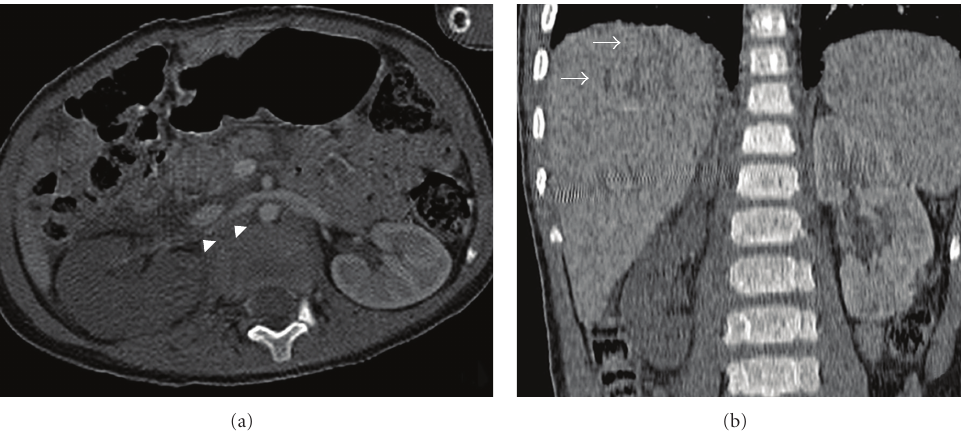
Figure 1: Axial curved reformatted image and coronal image of the abdomen showing normal proximal and middle segments of the renal artery (arrowheads) and no enhancement in the right kidney. Note the linear hypodensity in the liver compatible with laceration (arrows).